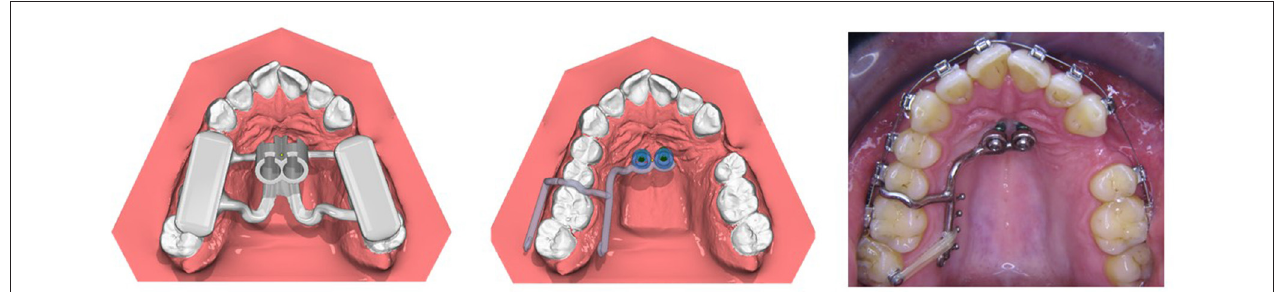
FIGURE 1 | CAD/CAM one-visit planning of mini-implant and orthodontic appliance